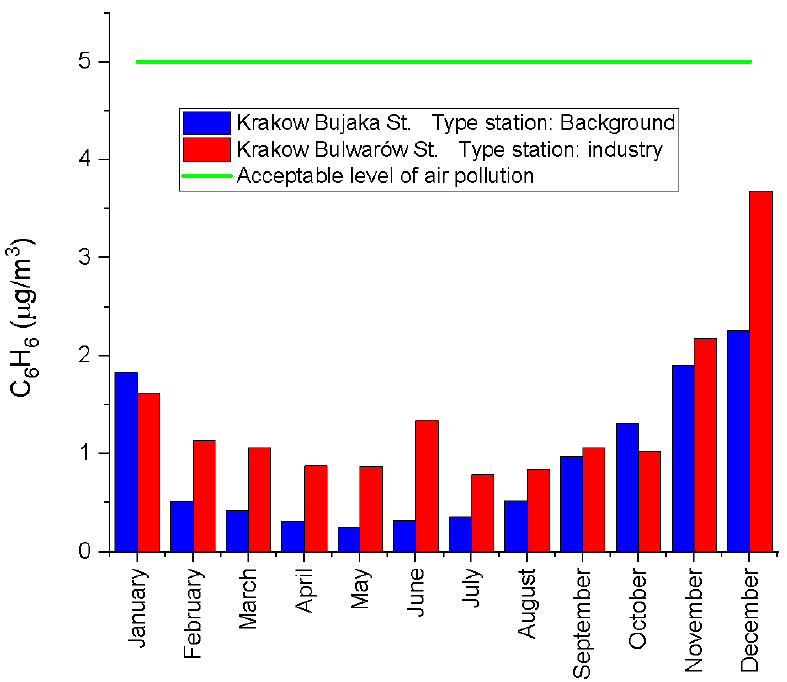
Figure 6. Average concentration of C 6 H 6 in individual months of 2020. The station on Kraków Bulwarów Str. had the greatest average As concentration, 1.71 ng m − 3 , while the station on Bujaka Str. had the lowest average As concentration, 1.66 ng m − 3 , with an allowed concentration of 6 ng m − 3 (Figure 7).